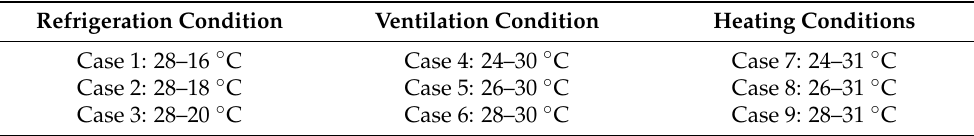
Table 6. Experimental conditions of the thermal environment in the unmanned